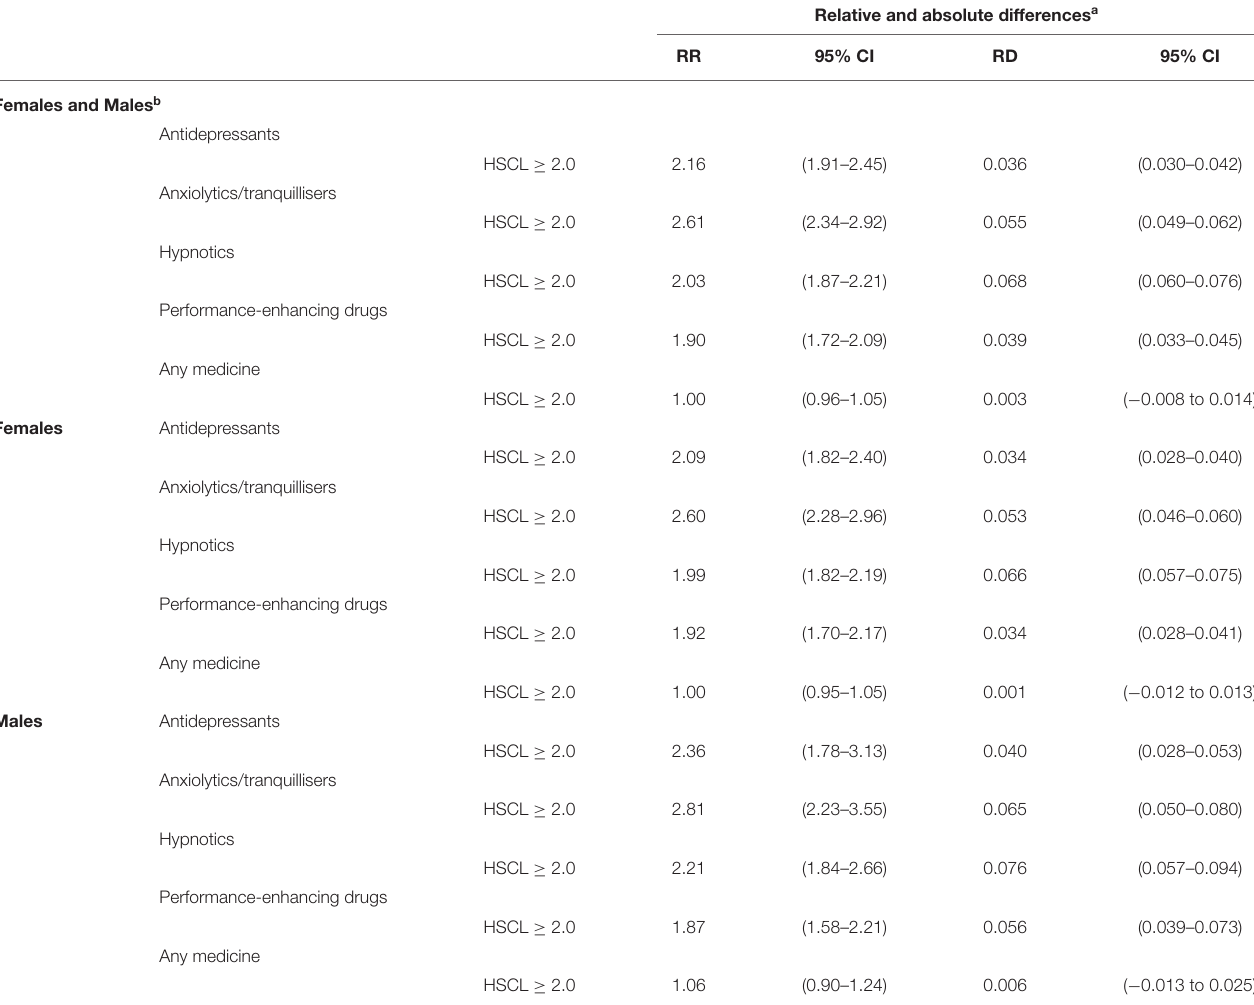
TABLE 3 | Adjusted a associations between psychological distress and daily psychotropic drug use, given by risk ratio (RR) and risk difference (RD) with 95 per cent confidence interval (95%